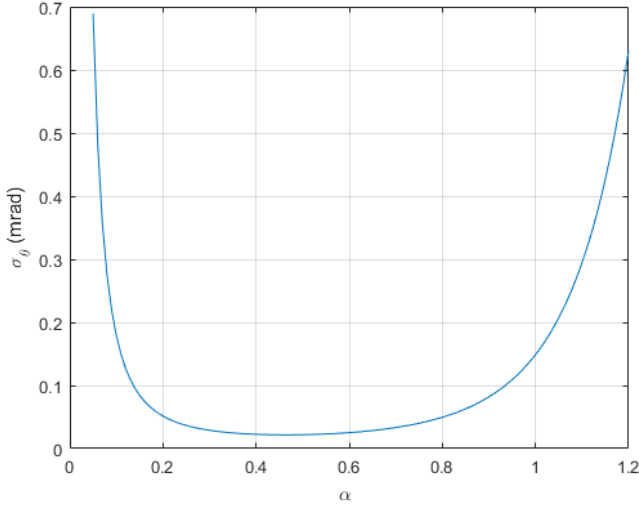
Figure 11. Angular error as a function of the ratio α .